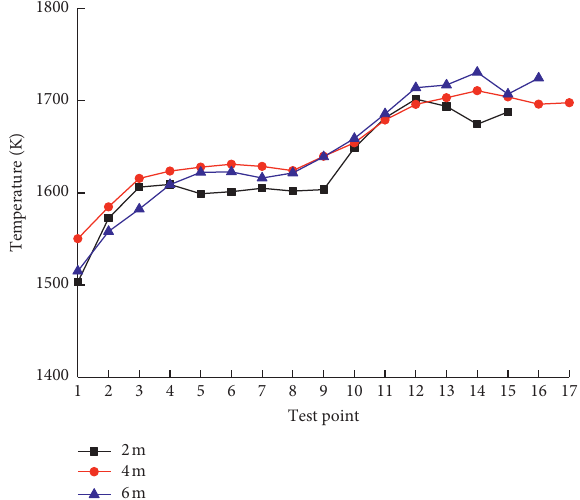
Figure 11: Curves of peak temperature under different inspection well depths.